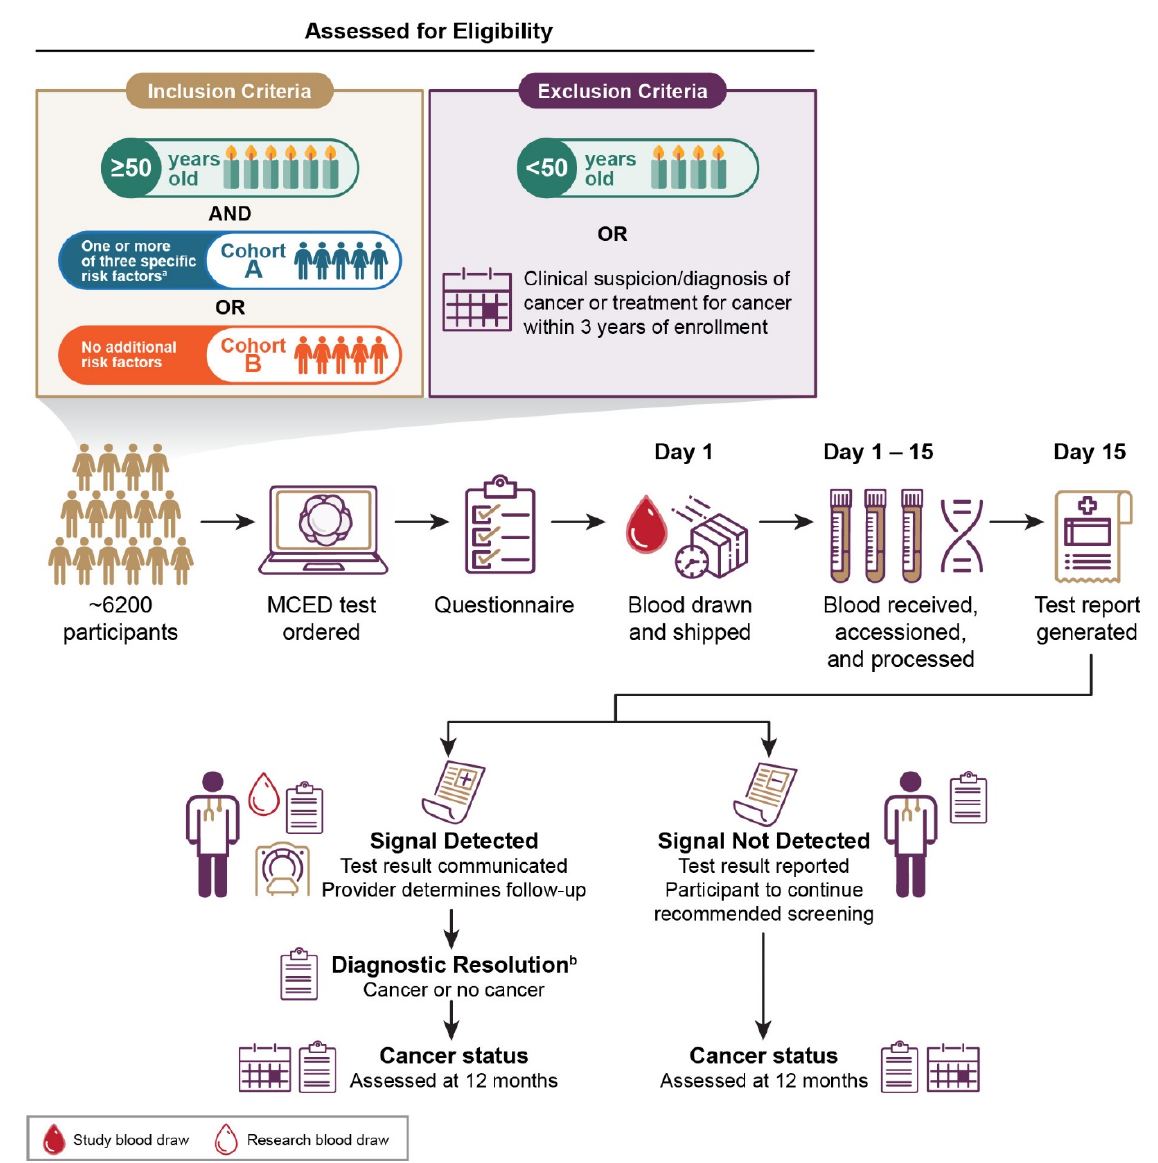
Figure 1. An overview of PATHFINDER study to evaluate the clinical implementation of a cell-free DNA-based targeted methylation multi-cancer early detection (MCED) test. Individuals 50 years or older are eligible to participate and will be divided into 2 cohorts depending on the presence or absence of additional cancer risk factors beyond age. Blood will be collected from ~6200 participants and analyzed with the MCED test. Test results (“signal detected” or “signal not detected” [defined as the presence or absence of cancer-associated DNA methylation patterns, respectively]) will be returned to participants and their physicians. Participants with a “signal detected” test result will undergo further diagnostic evaluation until diagnostic resolution is achieved. Participants with a “signal not detected” test result will be advised to continue usual medical care and guideline-recommended screening. Cancer status will be assessed in all participants 12 months after enrollment. Participants will also answer questionnaires several times during the study. Cancer risk factors assessed were lifetime smoking history of at least 100 cigarettes, genetic cancer disposition, and history of invasive or hematologic malignancy with definitive treatment 3 or more years before enrollment. a Participants “with additional risk” had ≥ 1 of the following risk criteria: a history of smoking ( ≥ 100 lifetime cigarettes), personal history of invasive cancer or hematologic malignancy with definitive treatment completed >3 years prior, or be at risk for and/or have a germline mutation associated with cancer susceptibility. b The diagnostic resolution is defined as the date when the study team determines to end diagnostic evaluation triggered by a “signal detected” test